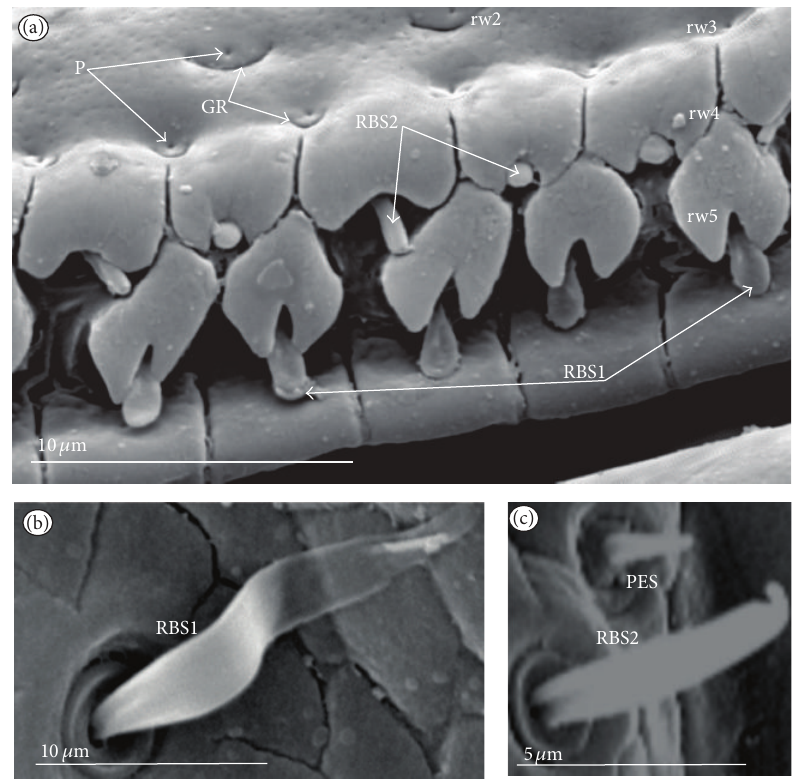
Figure3:TypesandsizesofthelabialsensillaoftheNepomorpha(Corixoidea).(a)RBSribbon-likesensillum.(b)RBS1ribbon-likesensillum, long. (c) RBS2 ribbon-like sensillum, short, PES peg sensillum. g: groove, p: pore, rw1, rw2: the first and second row of semicircular grooves, rw3: the third row with the pores, rw4, rw5: the fourth and fifth rows with the ribbon-like